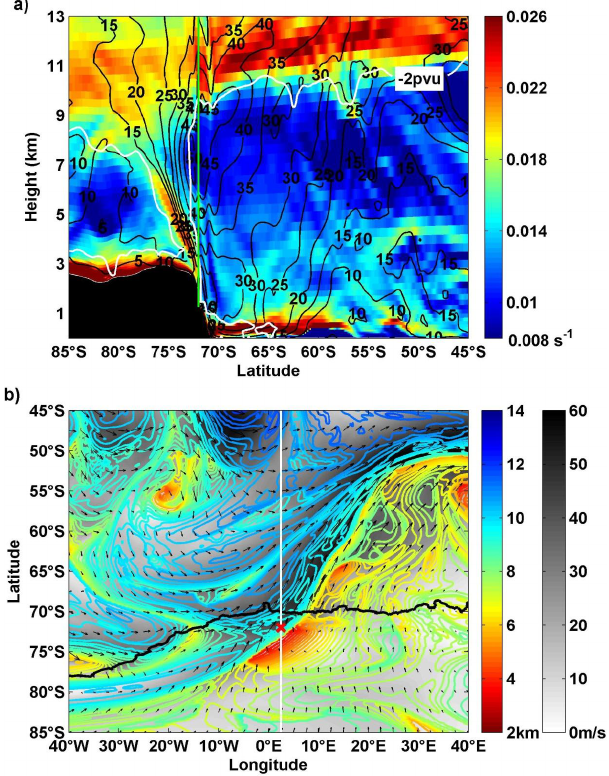
Fig. 2. ECMWF analysis on 22 June 2012, 06:00UTC. (a) Ver- tical cross section of buoyancy frequency along 2.5 ◦ E longitude. White line shows the dynamical tropopause level ( − 2pvu), and wind speed contours are indicated in black. Vertical green line rep- resents the position of MARA measurements. (b) shows the height, wind speed and direction at the dynamical tropopause level. MARA position is indicated by a red cross, and the vertical white line rep- resents the position of the cross section in (a)